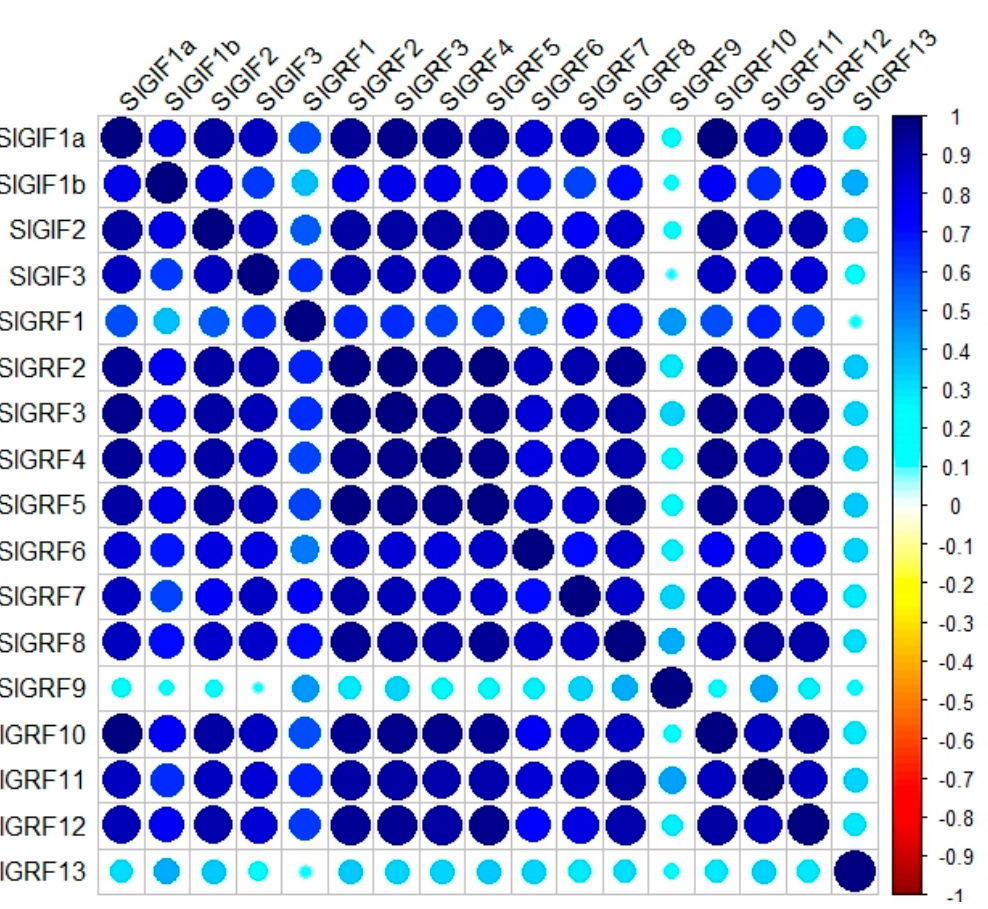
Figure 8. Co-expression between GIF and GRF genes in 536 tissues and samples. The sizes and colors of the circles indicate the values of the co-expression coefficients.